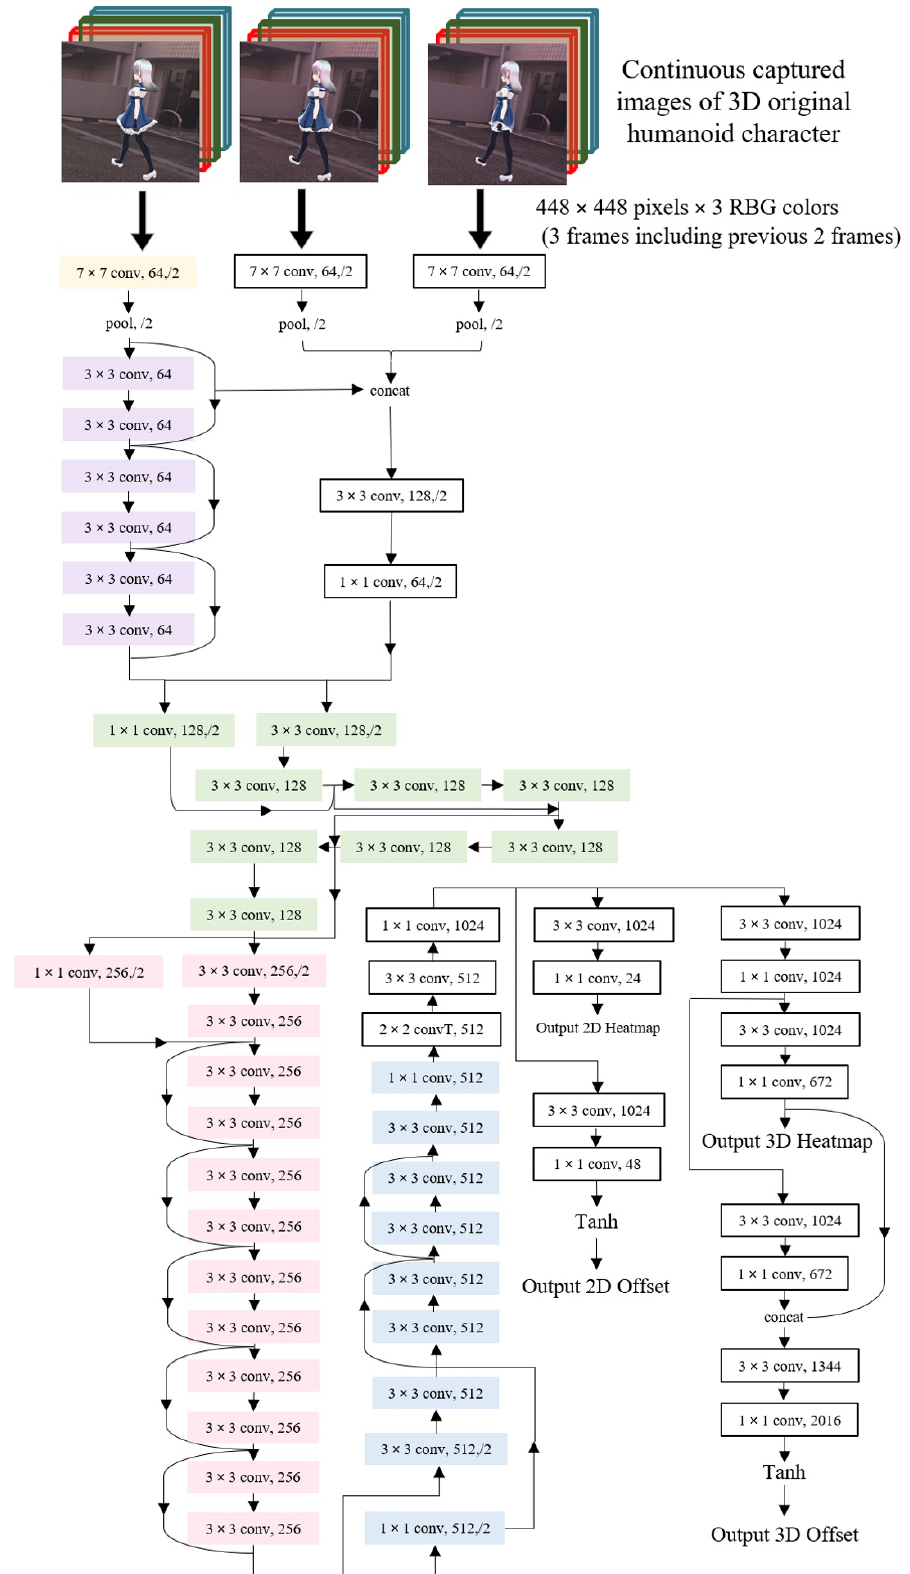
Figure 2. Overview of the training process and backbone network for the pose estimation framework. The colored cells are the basic cells designed using ResNet34, and the white cells are the added cells.